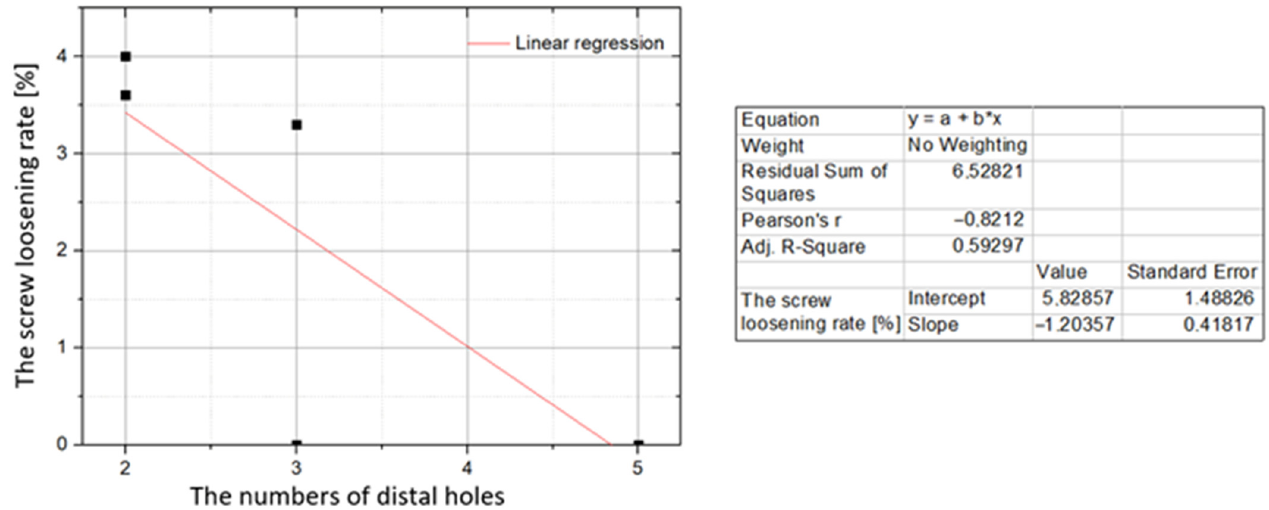
Figure 2. Correlation between the number of loosened osteosynthetic screws (vertical axis) and the number of fixations with 3D mini-plates (horizontal axis). Data for individual shapes of 3D mini-plates.